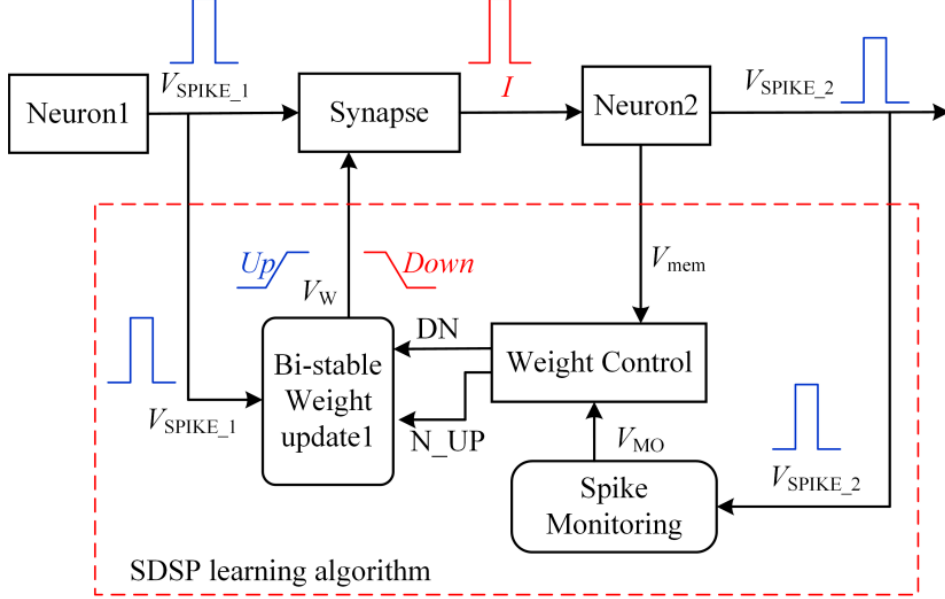
Figure 4. SDSP learning algorithm structure. When the output spike signal V SPIKE_1 from the pre-synaptic neuron is high, the SDSP regulates the synaptic weights by means of Equation (4). Otherwise, the SDSP pulls V W (t) toward the steady-state V MAX (1.8 V) or V MIN (0 V) via Equation (5). When V MO is not within the range shown in Equation (4) (V 1 –V 2 vs. V 1 –V 3 ), the SDSP algorithm does not regulate the synaptic weights, which prevents the neural network from over-regulating the synaptic weights during the learning